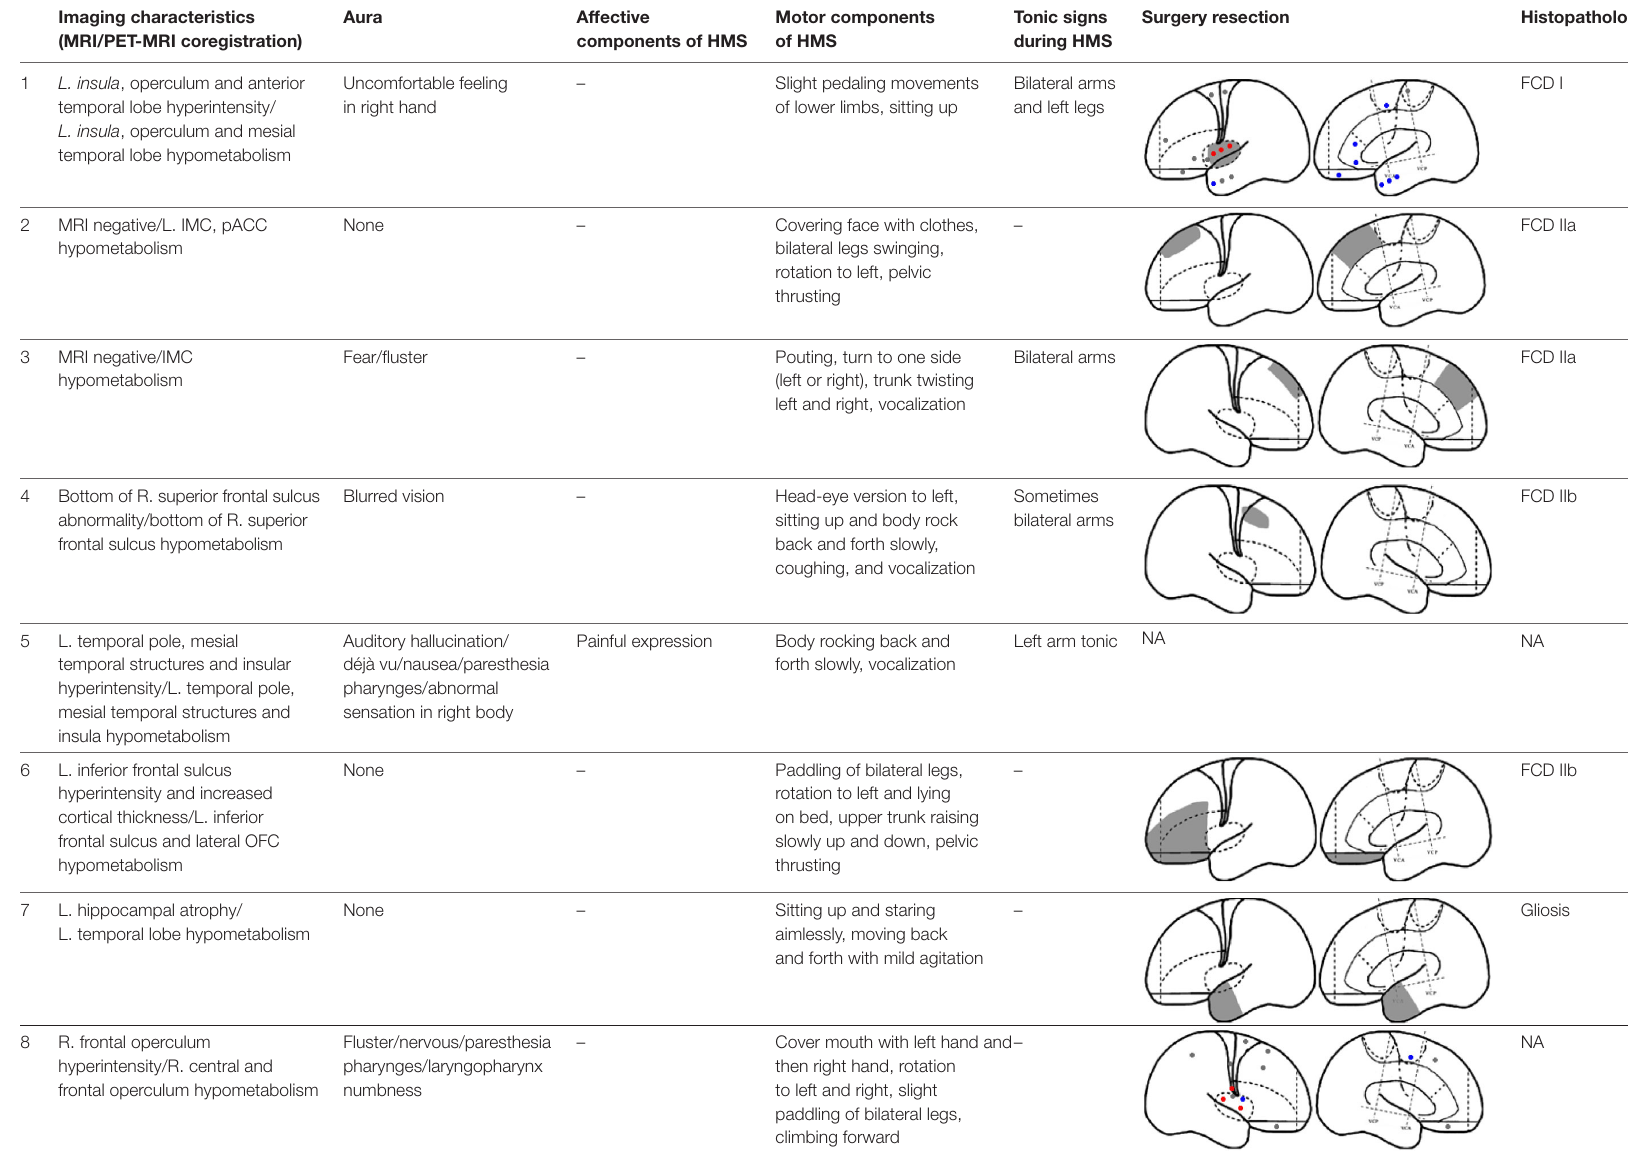
Table 2 | Seizure semiology and surgery resection in patients with HMS2. imaging characteristics (Mri/PeT-Mri coregistration)